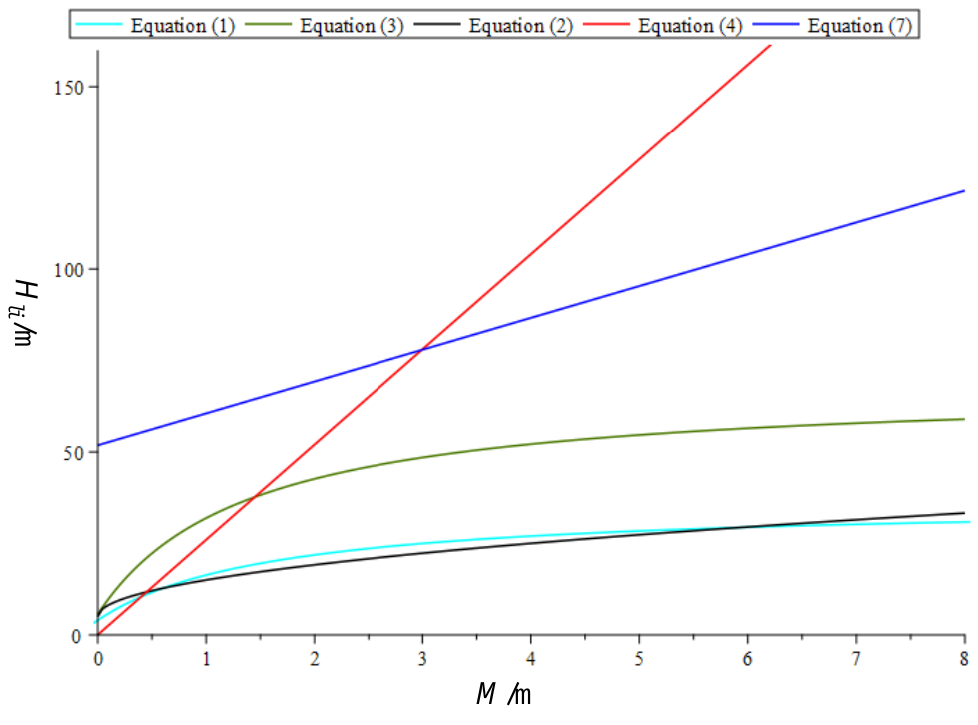
Figure 3. Comparison of equations for predicting DHWF. Table 2. Development height of WF.